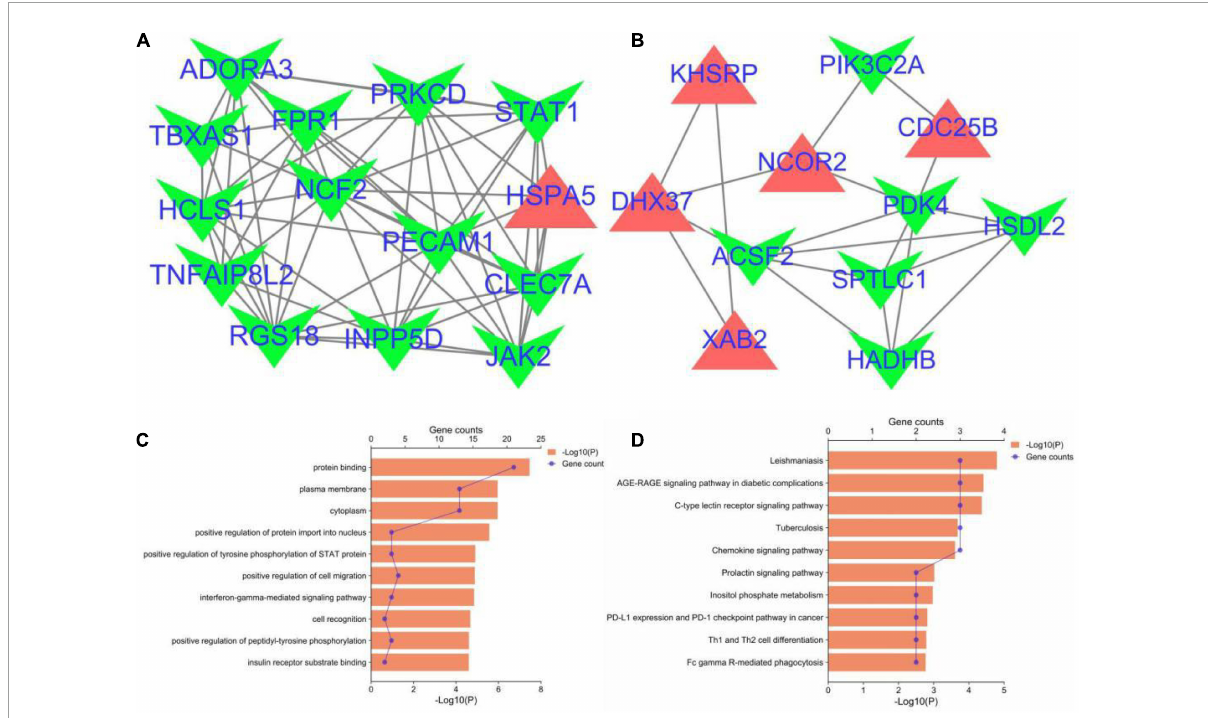
FIGURE3 Significant gene module and enrichment analysis of the modular genes. (A,B) Top two significant gene clustering modules. Red indicates upregulated genes and green indicates downregulated genes. (C,D) GO and KEGG enrichment analysis of the modular genes (top 10 terms of each category were